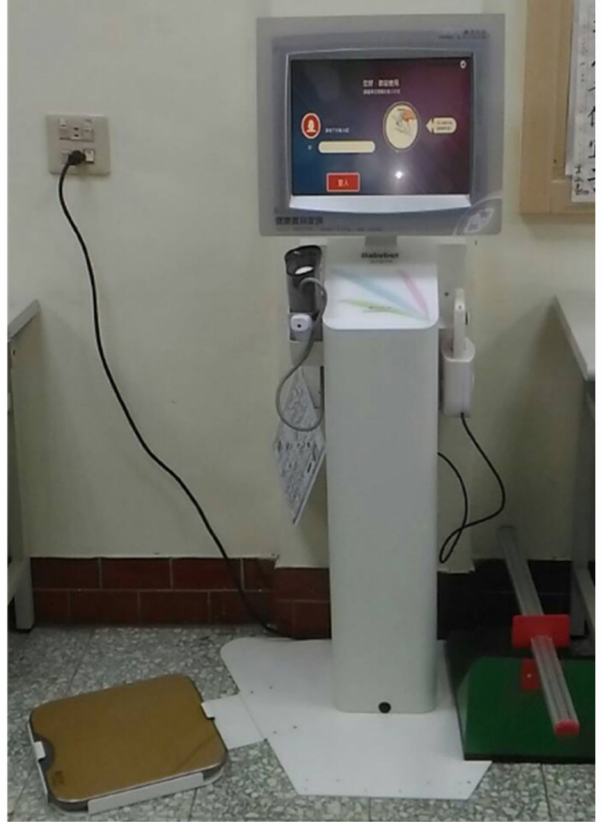
Figure 2. Smart Body Health Measuring